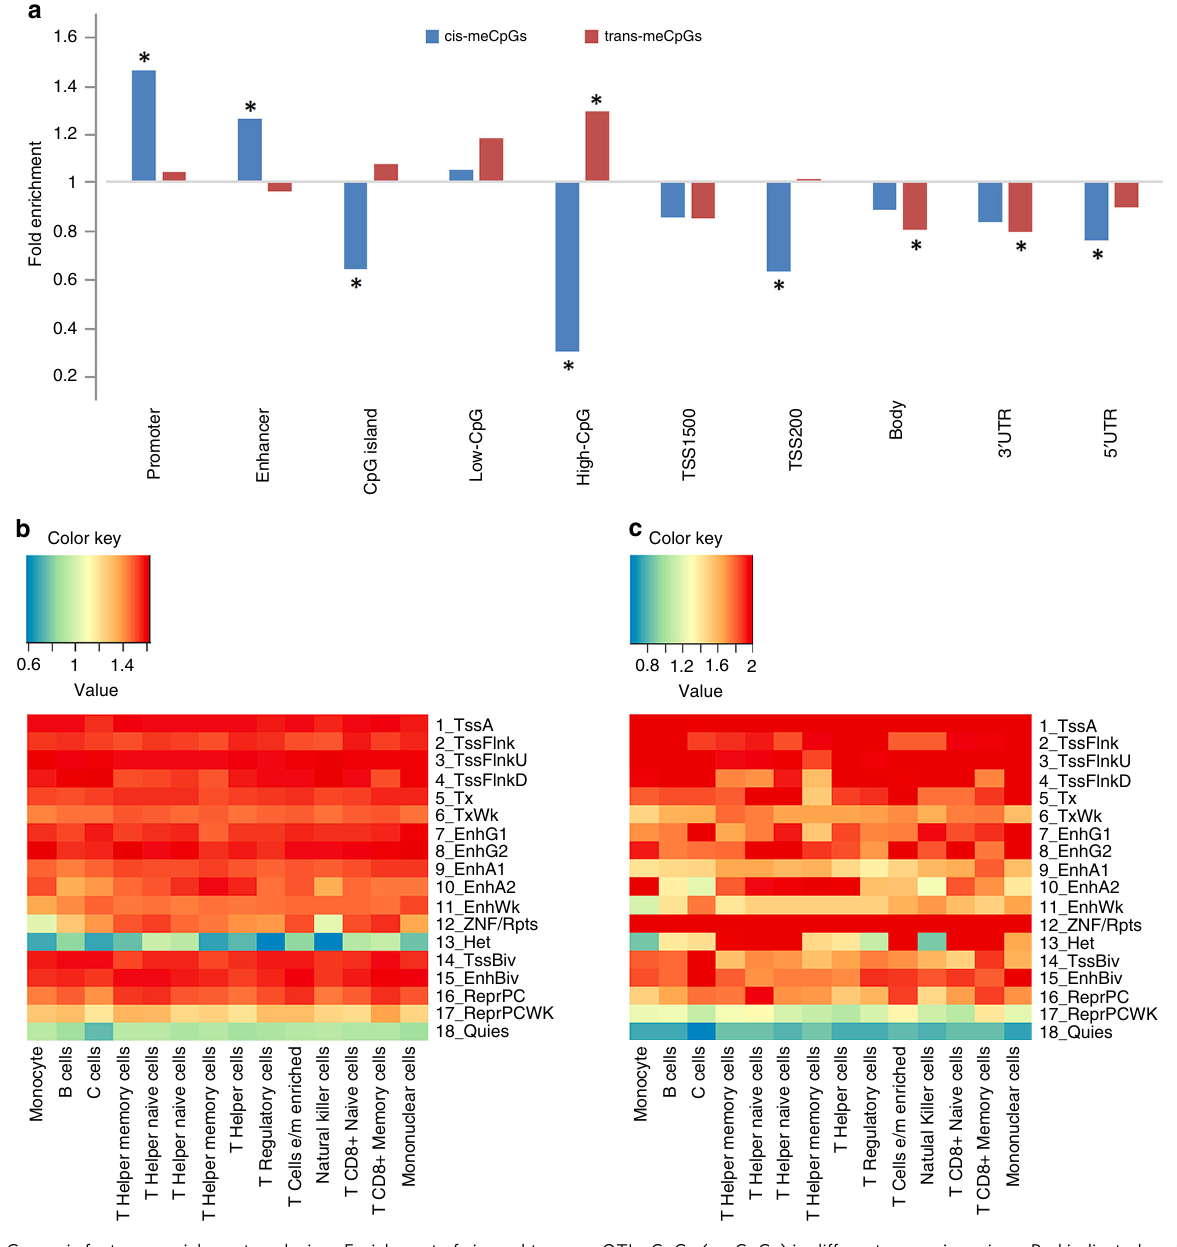
Fig. 4 Genomic features enrichment analysis. a Enrichment of cis- and trans- meQTLs CpGs (meCpGs) in different genomic regions. Red indicated positively associated and green indicated negatively associated. * Indicate signi fi cant results with fold change > 1.2 or < 0.8, and P < 0.05/10. b Enrichment of cis- meQTL SNPs in different chromatin states in 14 blood cell lines, including monocyte, B cells, T cells, T helper memory cells, T helper naive cells, T helper naive cells, T helper memory cells, T helper cells, T regulatory cells, T cells e/m enriched, Natural killer cells, T CD8 + naive cells, T CD8 + memory Cells, and mononuclear cells; c Enrichment of trans- meQTL SNPs in different chromatin states NATURE COMMUNICATIONS| (2019) 10:4267